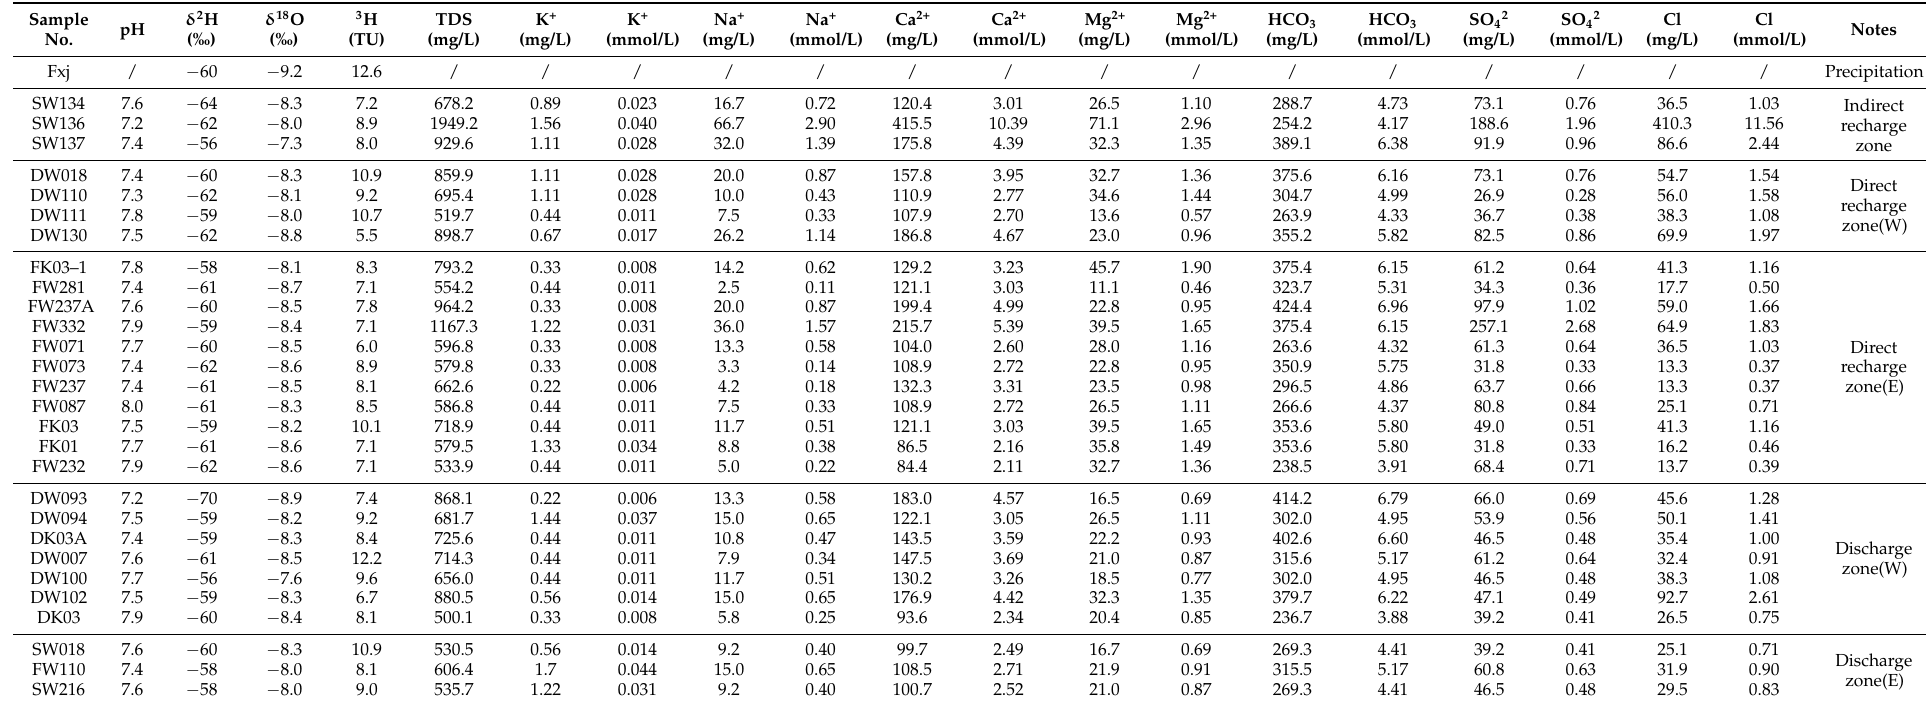
Table 2. Chemical composition of the water